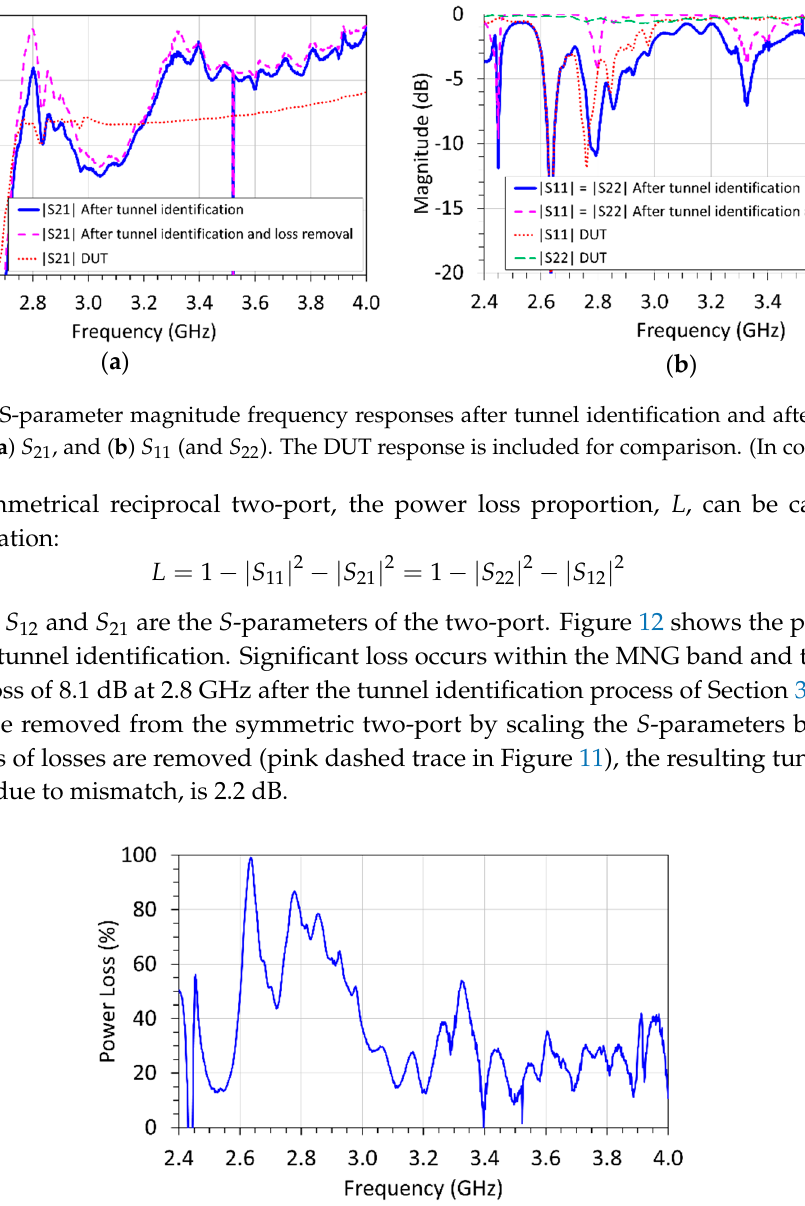
Figure 12. Power loss frequency response for the deembedded DUT.